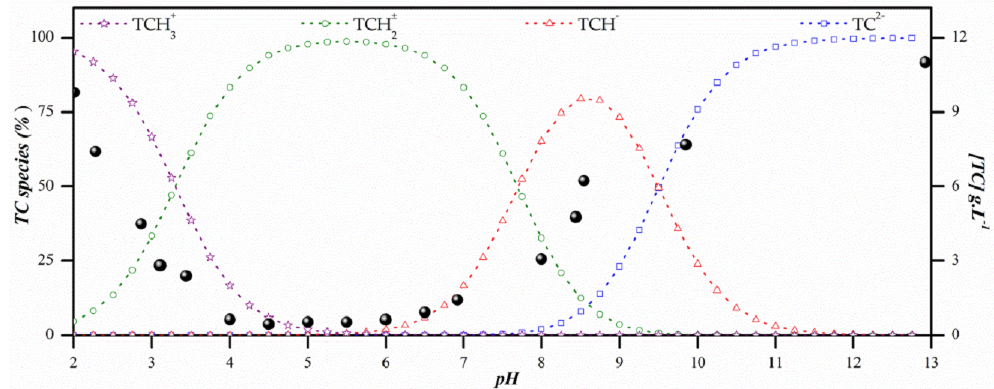
Figure 5. TC solubility curve and distribution of species as function of pH